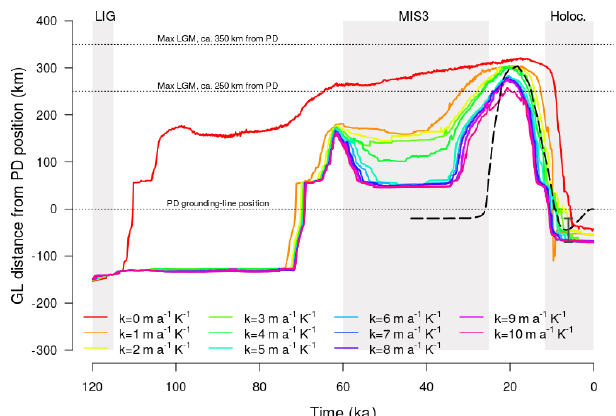
Figure 3. Simulated evolution of the NEGIS grounding line rela- tive to its observed present-day position for the set of experiments (coloured lines). The grounding-line distance has been calculated along 48 transects which approximately follow the flow direction of the NEGIS ZI glacier towards the shelf break (Fig. 2). The dashed black line shows the reconstruction by Larsen et al. (2018). Shaded regions represent the time periods corresponding to the LIG, MIS-3 and Holocene. The three dotted lines show the PD NEGIS grounding-line position (0km) and the maximum (300km ± 50km) expected advance of the north-east GrIS to the continental shelf break during the LGM according to Funder et al.